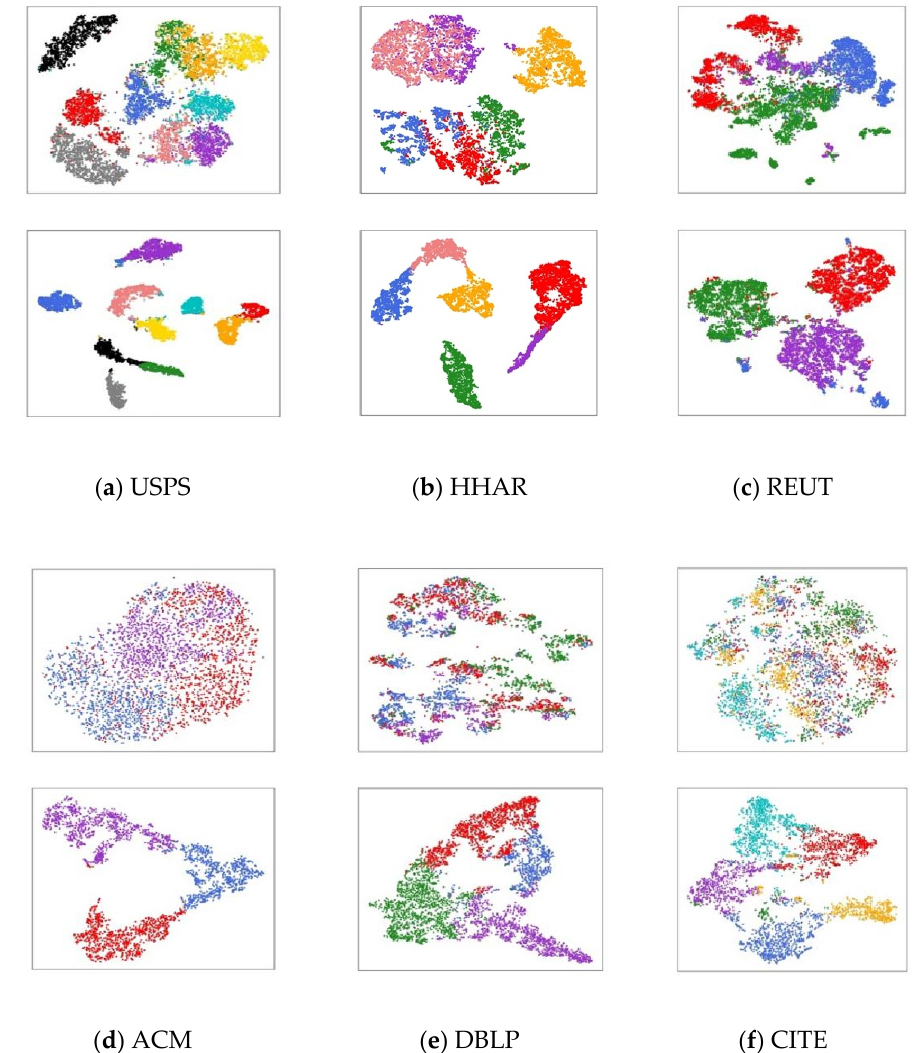
Figure 4. The visualization results on six datasets. The first and second rows correspond to the original data and CDFG, respectively.